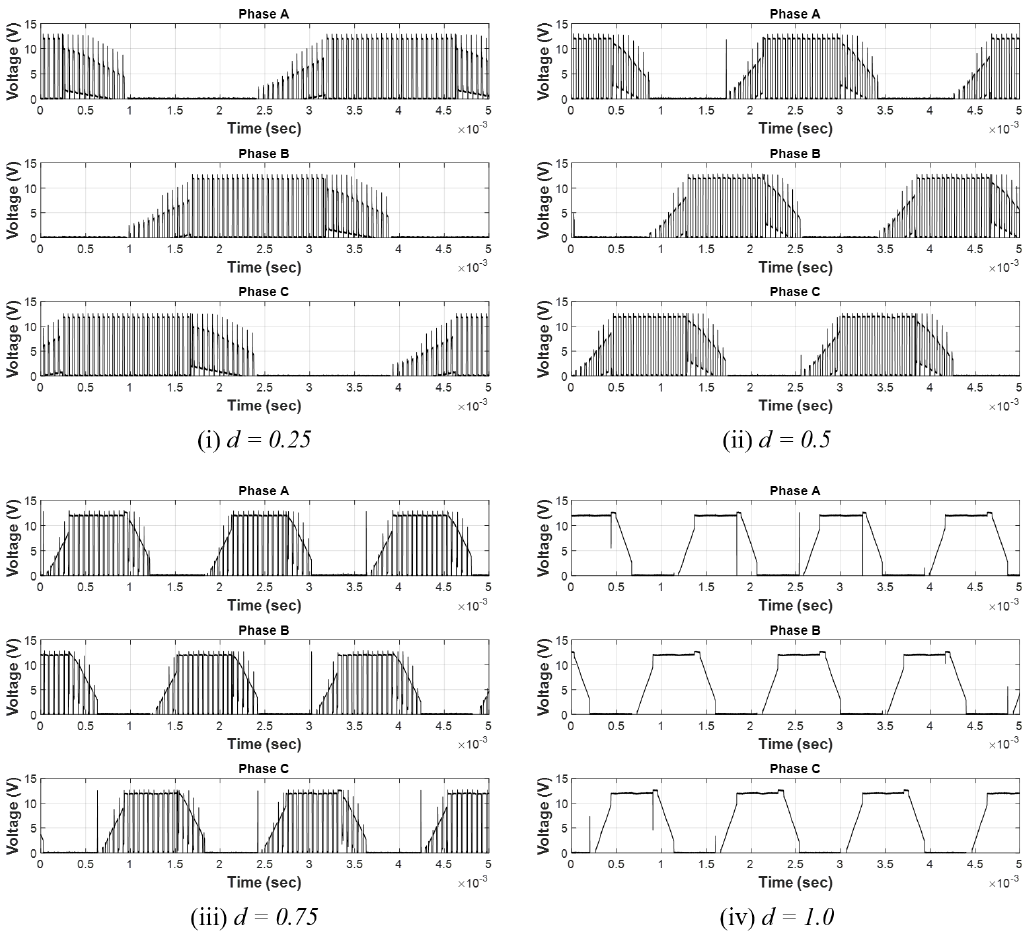
Figure 8. Actual three phase voltage waveform measured by